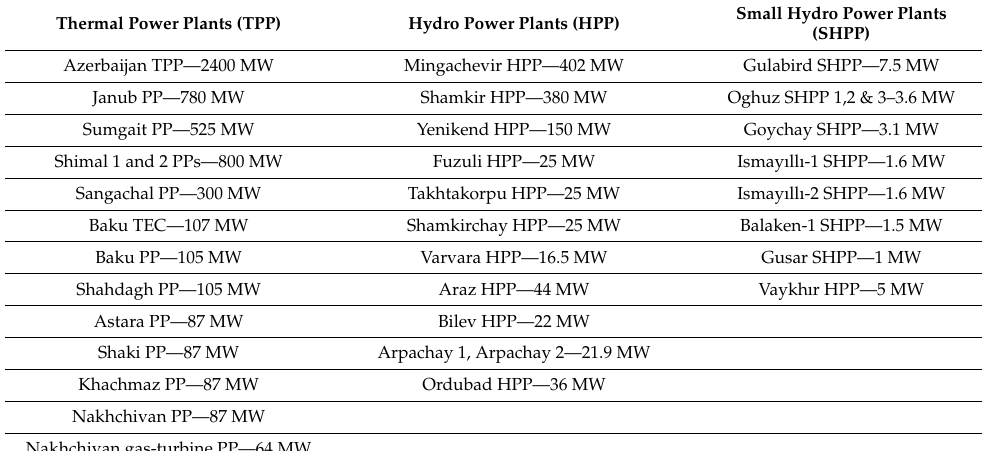
Table 3. Power generating plants in Azerbaijan [15].